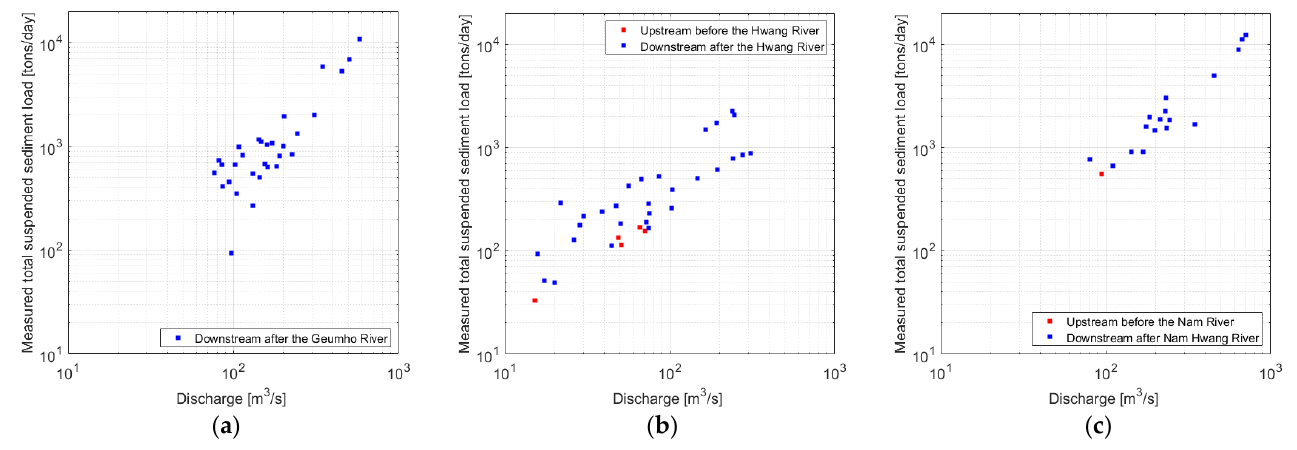
Figure 7. Measured total suspended sediment load at ( a ) Geumho, ( b ) Hwang, and ( c ) Nam River.